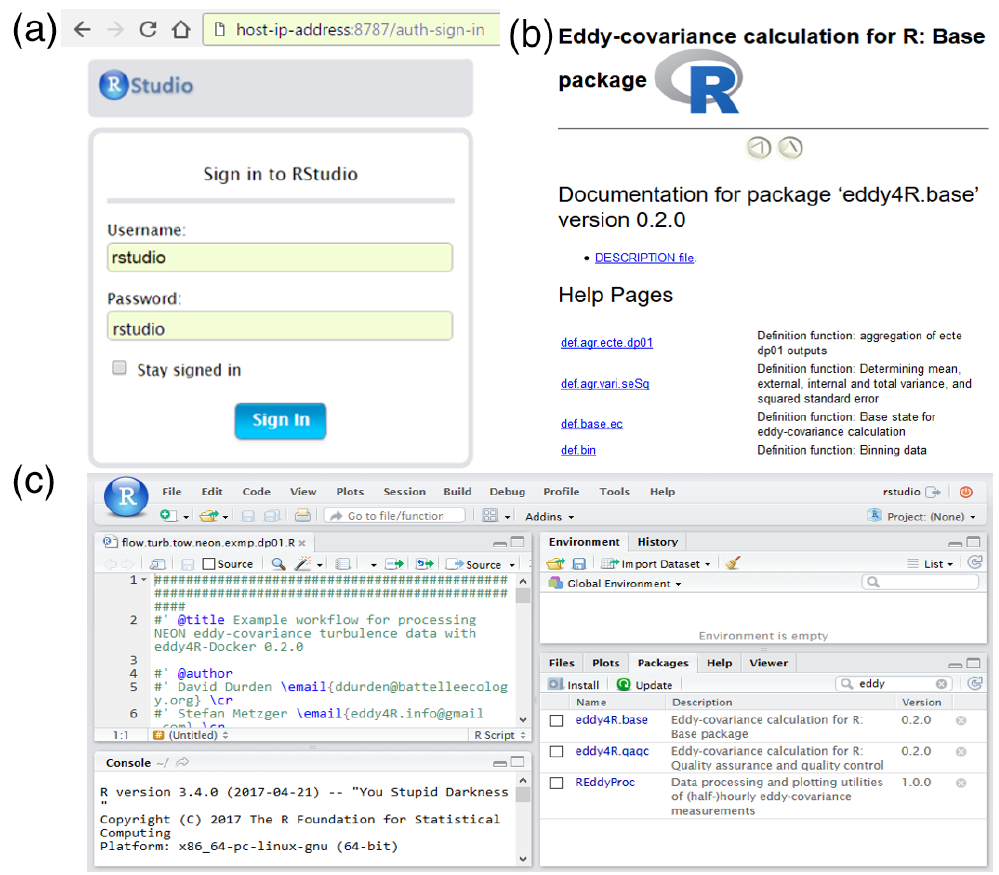
Figure 7. Docker-based RStudio server session via web browser. (a) Sign-in screen with highlighted areas showing information to input by the user. (b) Interactive help for the eddy4R.base package. (c) Integrated development environment with workflow template, R console, Git staging area, and eddy4R